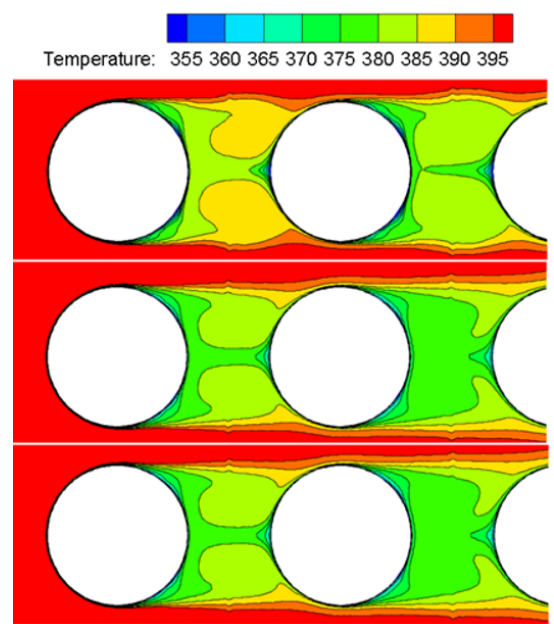
Figure 5. Temperature contour for different time step sizes (top = 0.5 s, middle = 0.01 s, bottom = 0.005